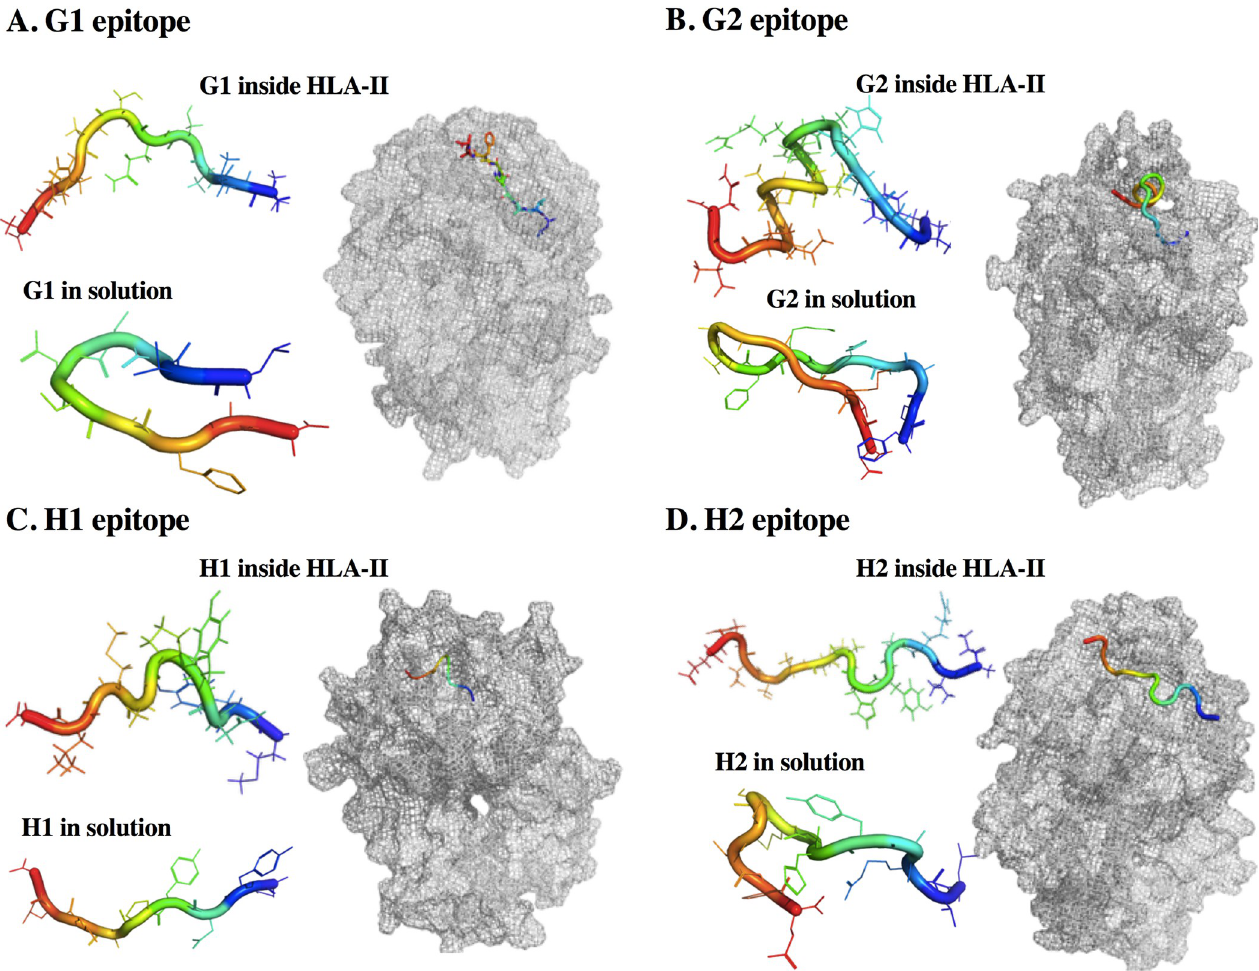
Fig 6. Average structures from epitopes in solution and HLA-epitopes complexes. (A). G1 epitope. (B). G2 epitope. (C). H1 epitope. (D). H2 epitope.